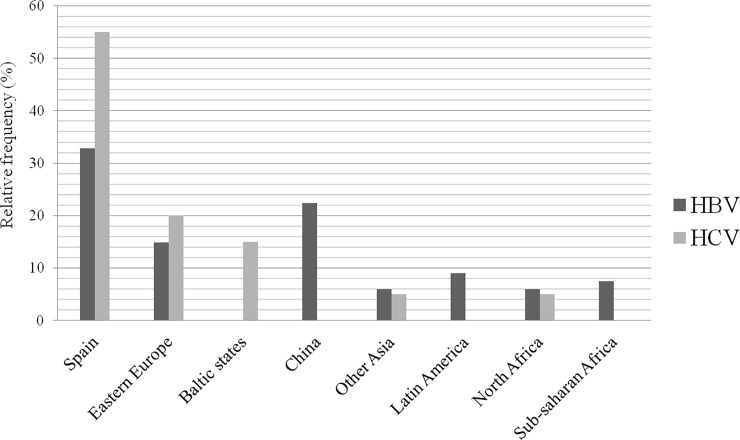
Geographic origin of pregnant women with HBV or HCV infection.This figure shows the geographic origin of the pregnant women with HBV or HCV infection who participated in the epidemiological study, expressed in relative frequency.